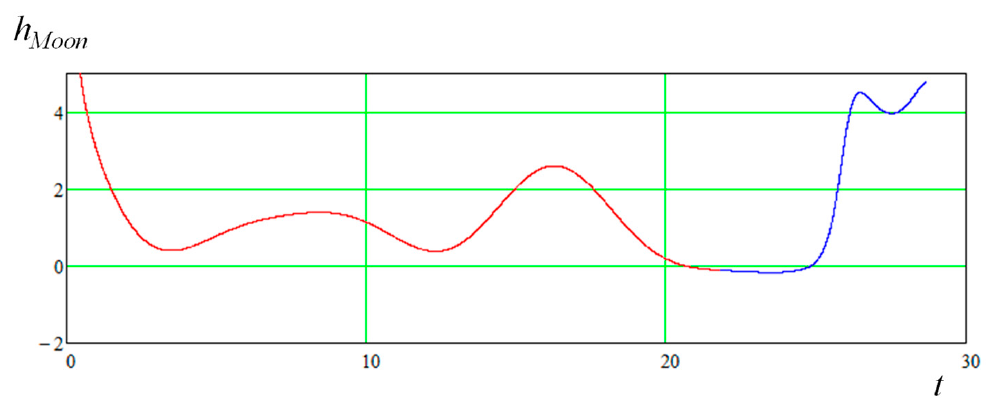
Figure 18. Selenocentric energy of the spacecraft [undim.] along the transfer trajectory. The blue color corresponds to the “near-lunar” section of the motion starting from time t 1 to t 1 + (cid:101) ∆ t f . The presented figure clearly shows two close successive approaches to the Moon, which quite naturally fall on the area of the “circumlunar” motion of the spacecraft (blue curve). It is clear that both of these approaches correspond to passages of the periapsis of the osculating elliptical selenocentric orbit. First of all, it is required to estimate the height of these passages. Therefore, we construct a dependence that describes the change in the relative distance between the radius vector of the SC center of mass and the circular selenocentric orbit of a given altitude during its movement along the circumlunar part of the trajectory. Obviously, the corresponding dependence directly reflects a condition of the form (16). It is shown in Figure 25.